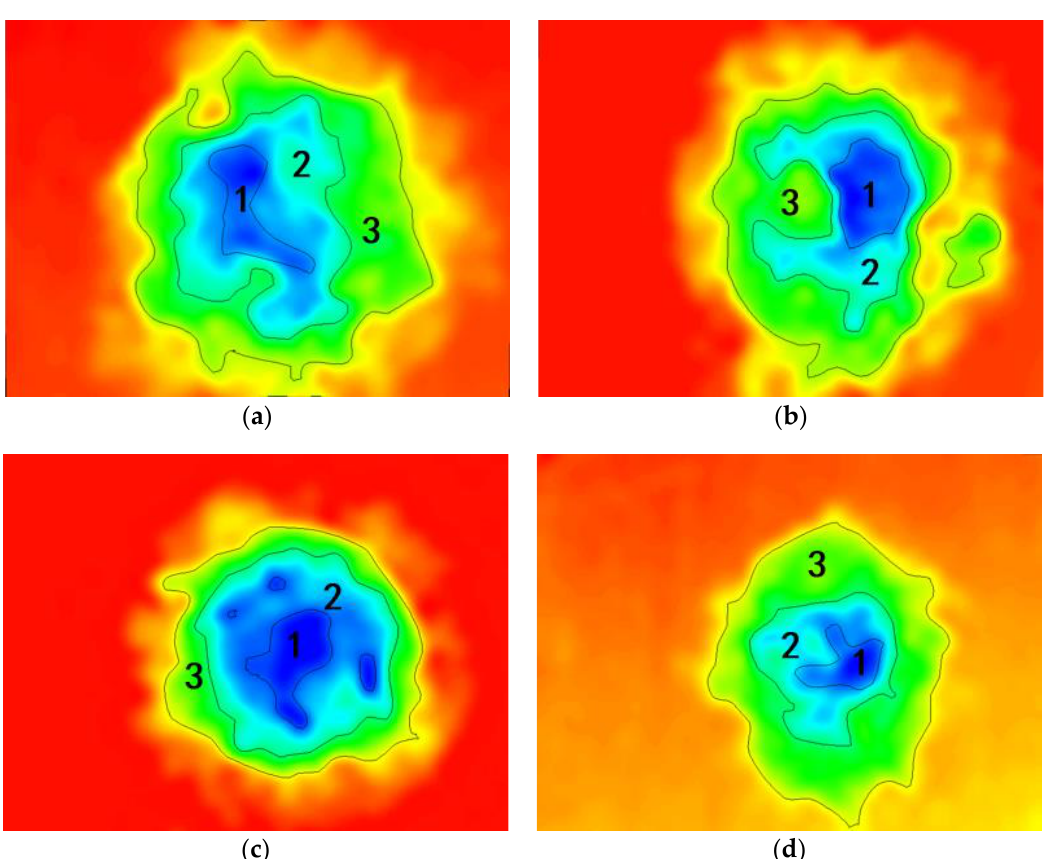
Figure 13. Body microscopic corrosion analysis of metal substrate immersed for 31 d: ( a ) C1; ( b ) C2; ( c ) C3; and ( d ) C4. Table 4. Carrier density after immersion for 1 d, 11 d, 21 d, and 31 d.